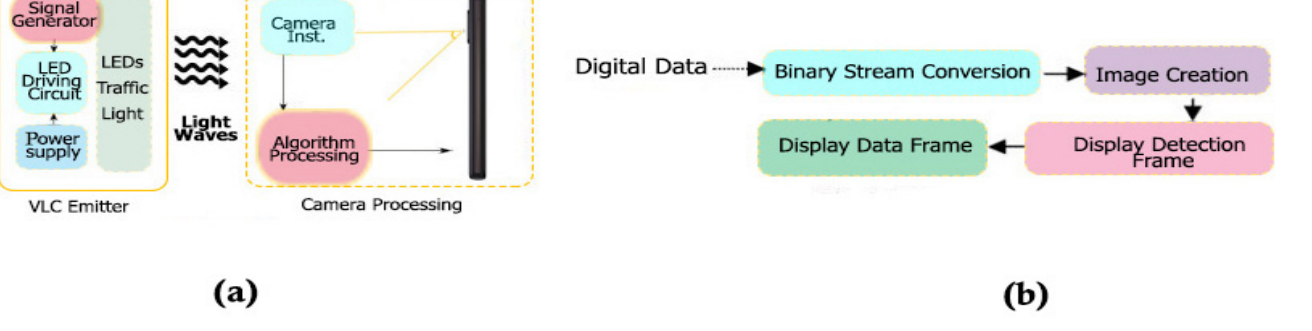
Figure 8. Illustration of an S-VLC communication system, which uses smartphones for reception and a street light for transmission.